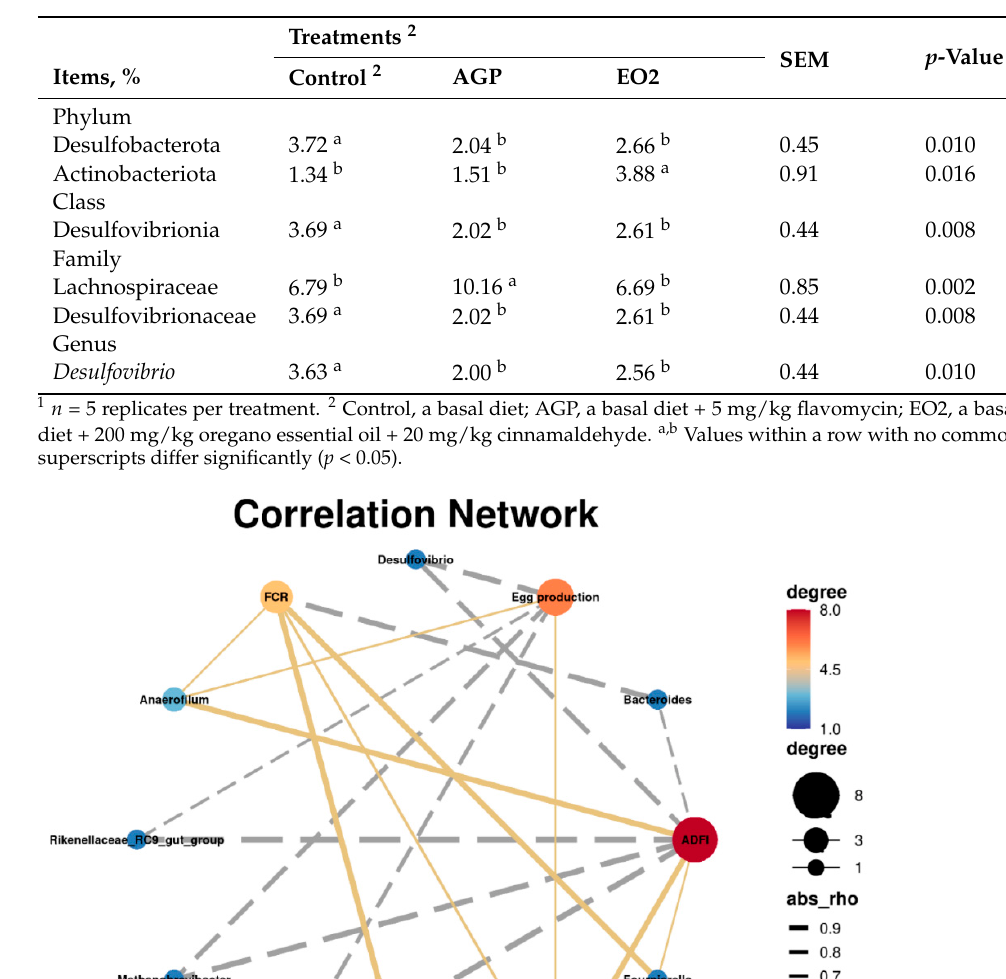
Table 6. Differences of bacterial distribution in cecal digesta between the control, AGP, and EO2 groups 1 .